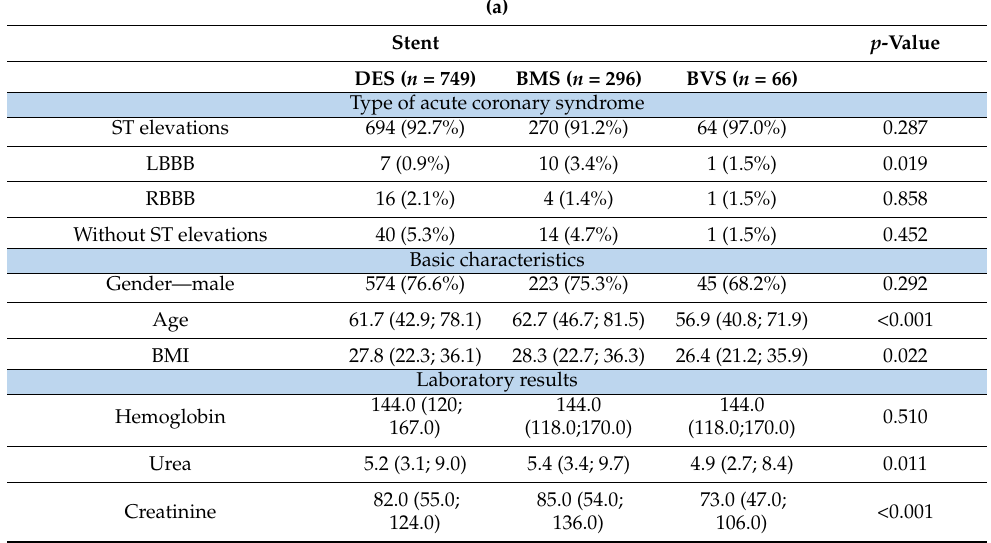
Table 1. (a) Comparison of basic clinical parameters between patient groups according to stent type (DES vs. BMS vs. BVS). (b) Comparison of procedural parameters between patient groups according to stent type (DES vs. BMS vs.